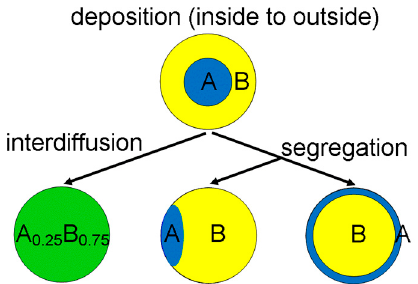
Figure 1. Sketch distinguishing the effects of diffusion and segregation in quantum dots. Colour is used to ascribe the chemical composition where pure A is blue (deposited first), pure B is yellow and an alloy AB is green.